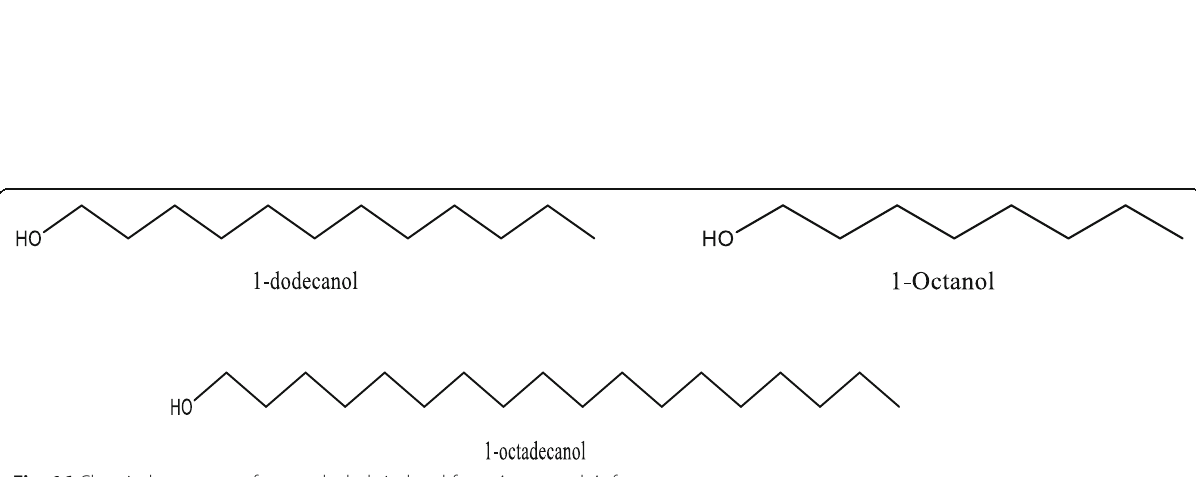
Fig. 16 Chemical structures of some alcohols isolated from A. vera and A.